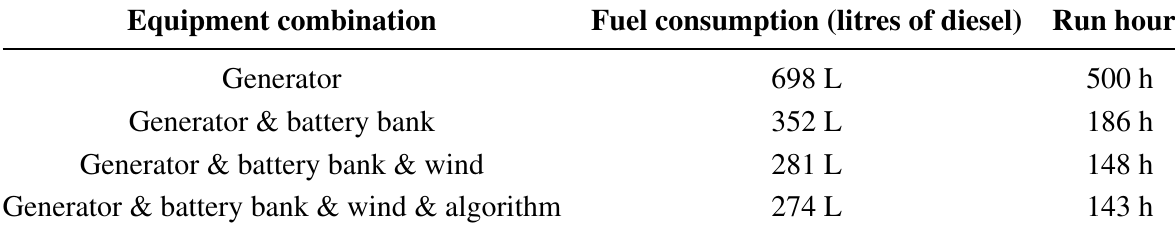
Table 3. Relative fuel cost of different energy configurations in 500 h model